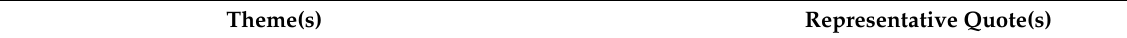
Table 3. Contrasting themes between rural and urban schools for capacity